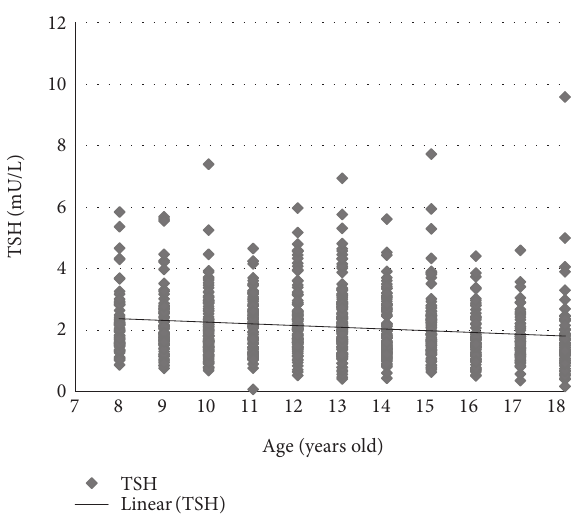
Figure 1: Distribution of TSH according to age categories.